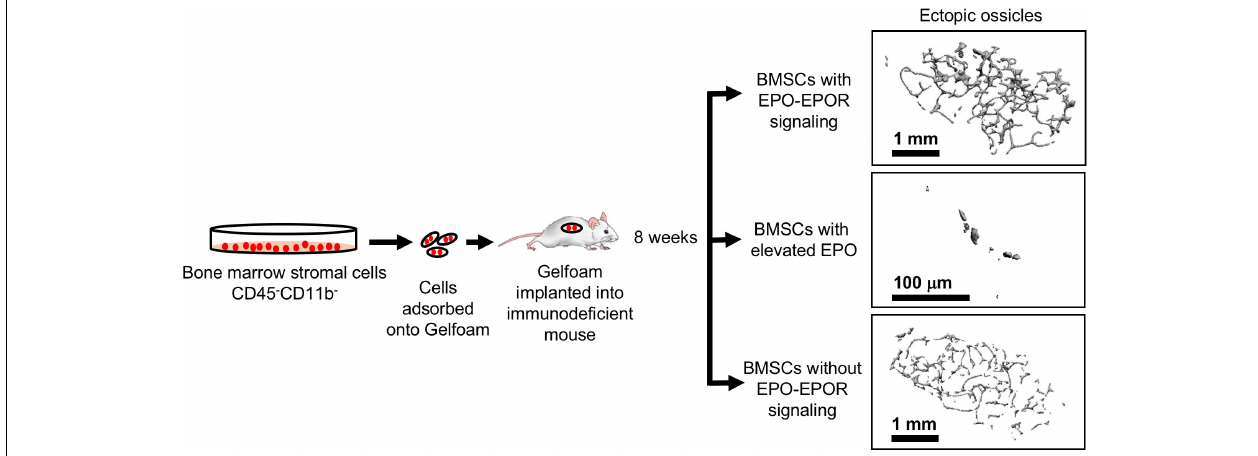
FIGURE 7 | Ectopic bone formation assay with BMSC. Adherent BMSC were selected from cultures of bone marrow cells harvested from wild type and genetically altered mice. Cells were absorbed into Gelfoam and surgically transplanted into immunocompromised NSG mice (Jackson Laboratory). After 8 weeks, ectopic bone ossicles formed and were analyzed by micro-CT. Ossicles formed in transplants from (cid:49) EpoR E mice that lack EPOR in non-hematopoietic tissue (bottom) showed similar structure to control mice (top) with a trend toward fewer trabeculae, consistent with a reduction in endogenous bone formation in (cid:49) EpoR E mice. Bone formation was markedly reduced with hardly any trabecular bone in ossicles in transplants from transgenic mice expressing high level of human EPO (Ruschitzka et al., 2000) (middle) compared with control mice (top) , reflecting the even greater reduction of endogenous bone formation in these transgenic mice compared with (cid:49) EpoR E mice and control mice (modified from Suresh et al., 2019, with permissions).